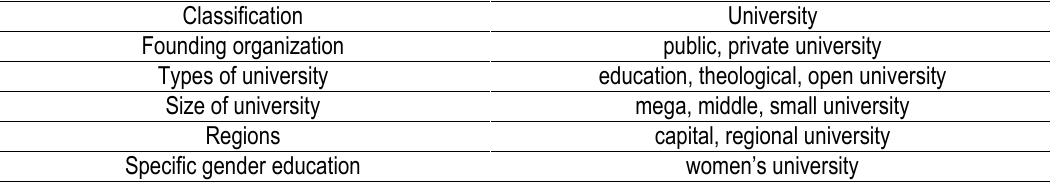
Table 2. Classification of